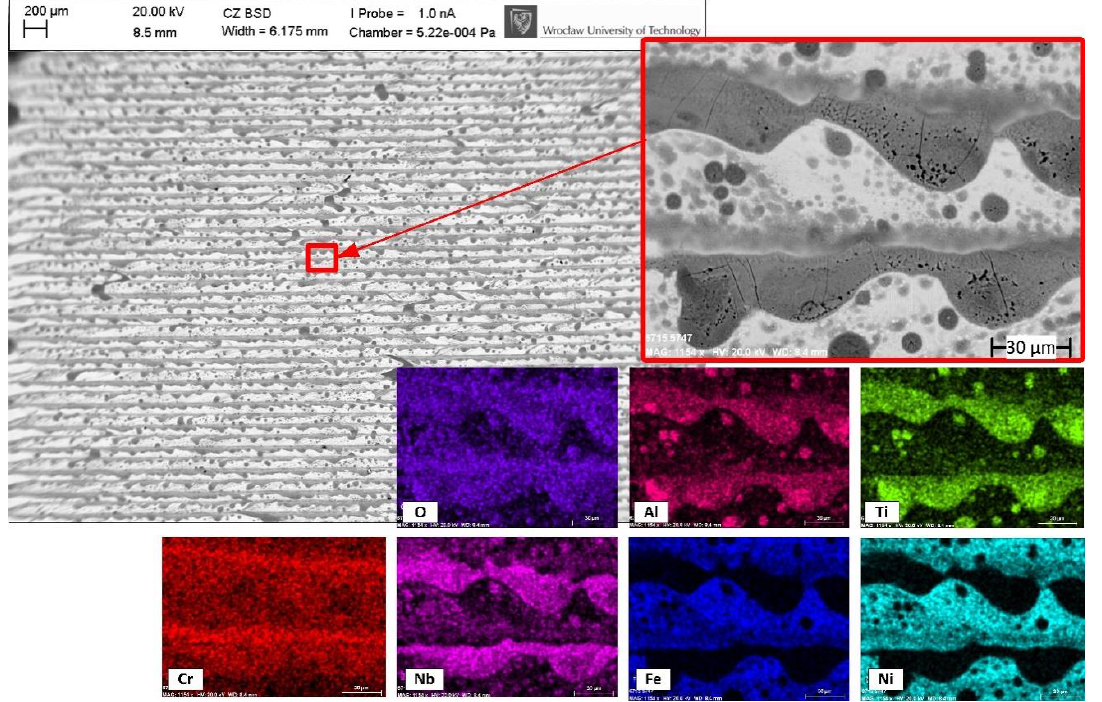
Figure 6. Back-scattered electron graph and EDS mapping showing the top-view and chemical elements of the sample (5.o) polished with 85% overlap in the air atmosphere.